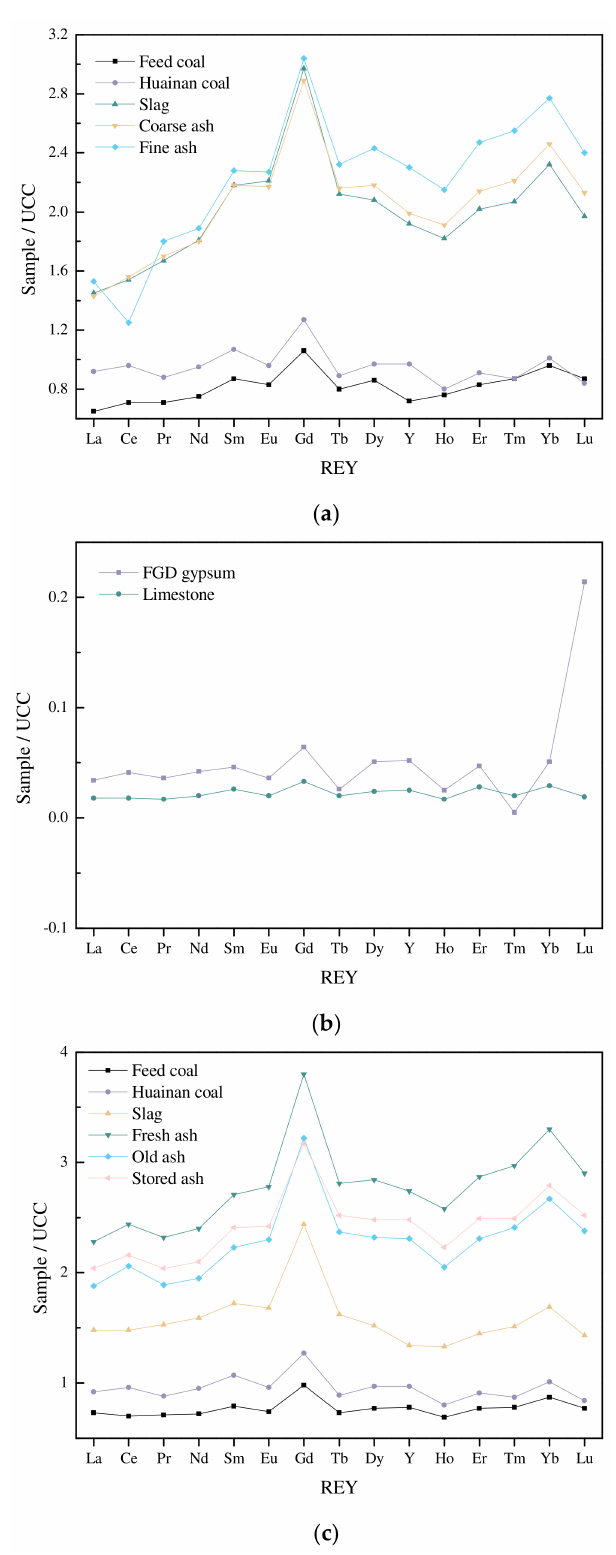
Figure 5. UCC-normalized REY distribution patterns of the feed coal and various ashes ( a ) and limestone and FGD gypsum ( b ) from the WN power plant, and the feed coal and various ashes from the TY plant ( c ). Data of REY in the Huainan coals and the Upper Continental Crust were cited from Zhang et al. [28] and Rudnick and Gao [34],